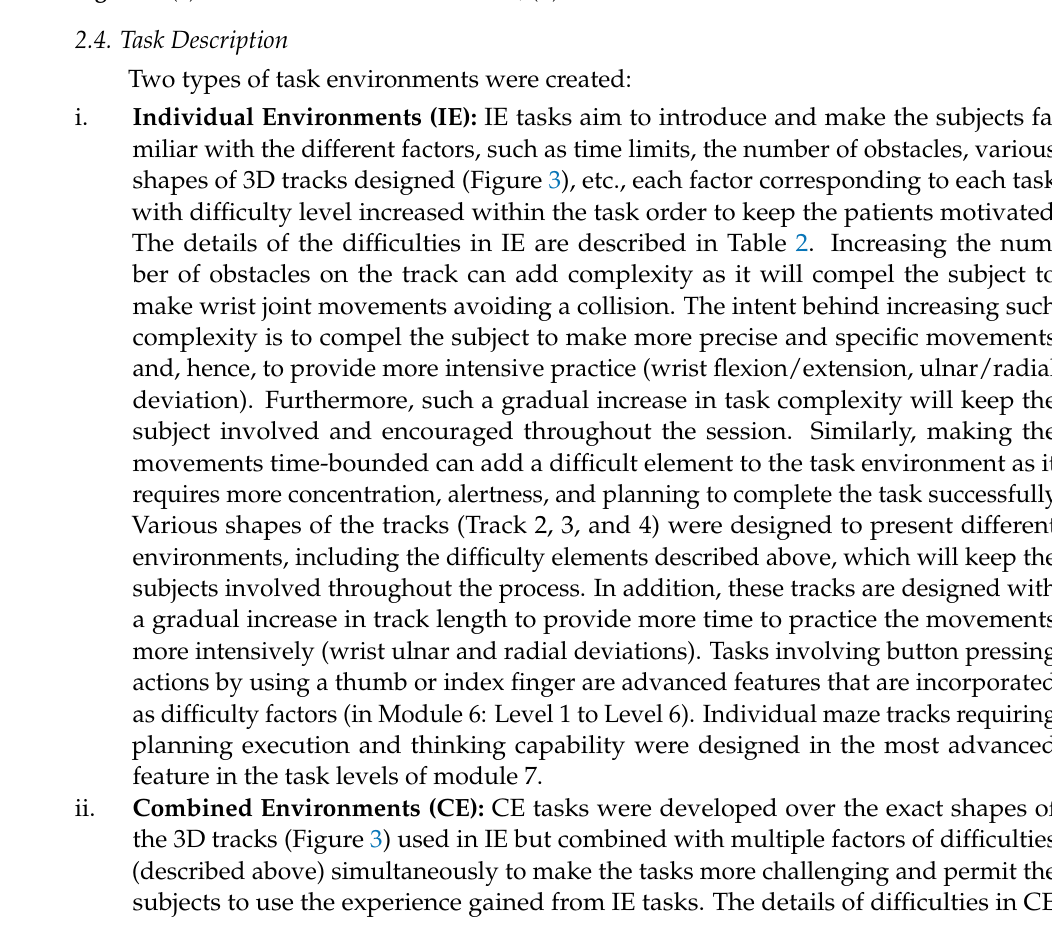
Figure 2. ( a ) Obstacles and task environment; ( b ) GUI and visual feedback on